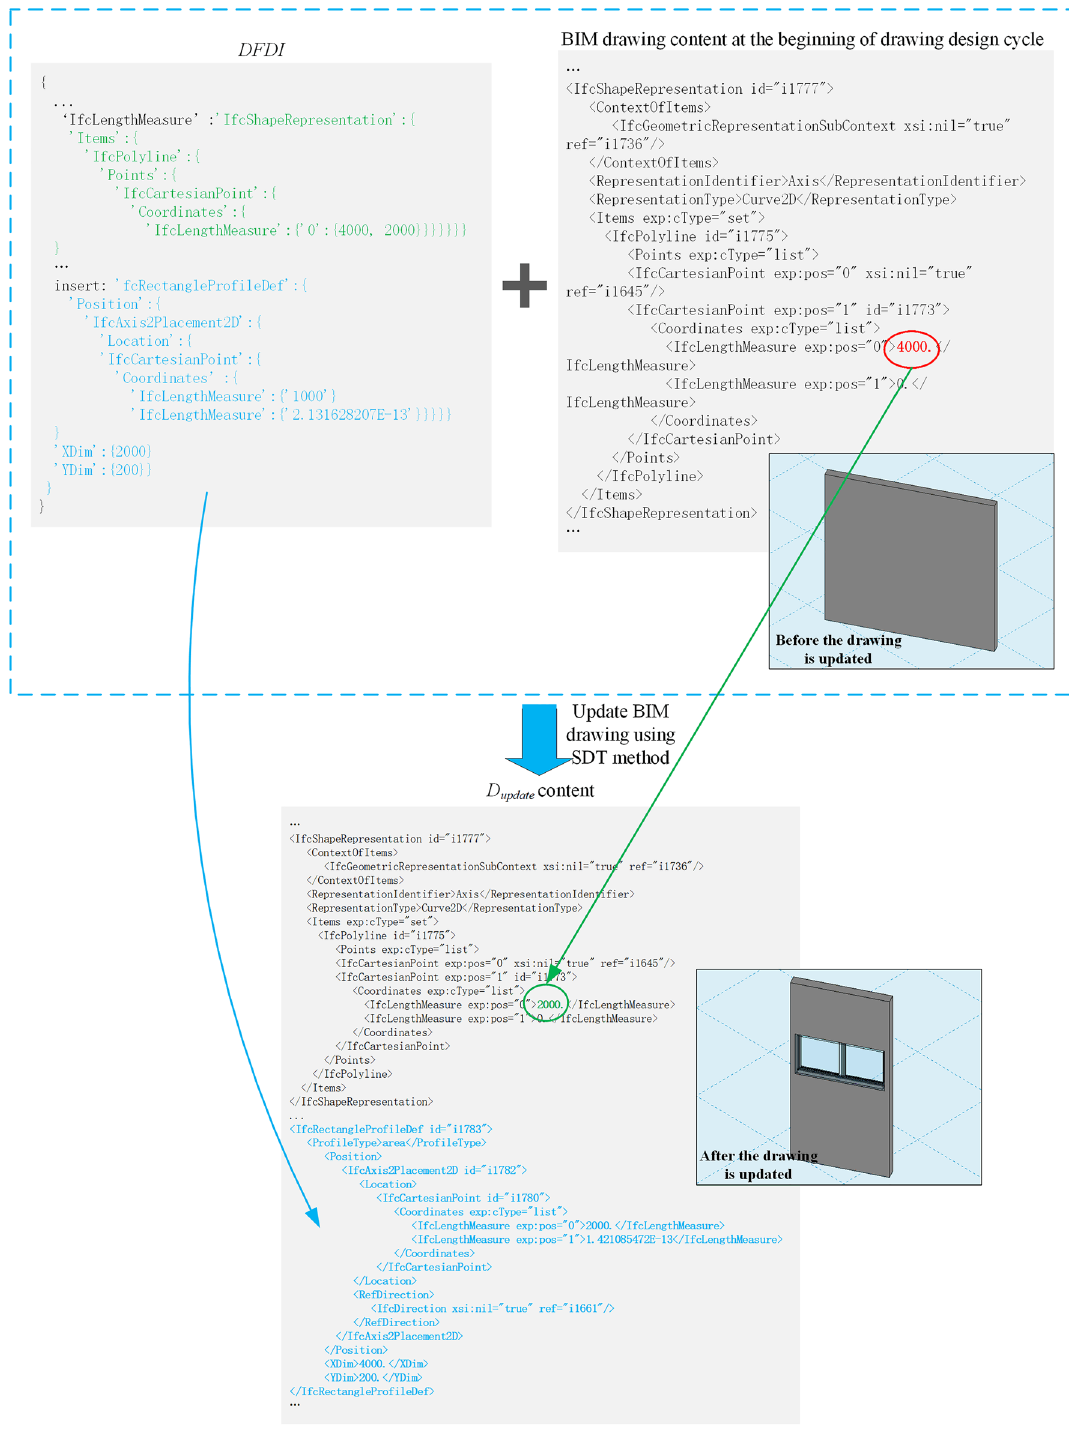
Figure 12. BIM drawing update